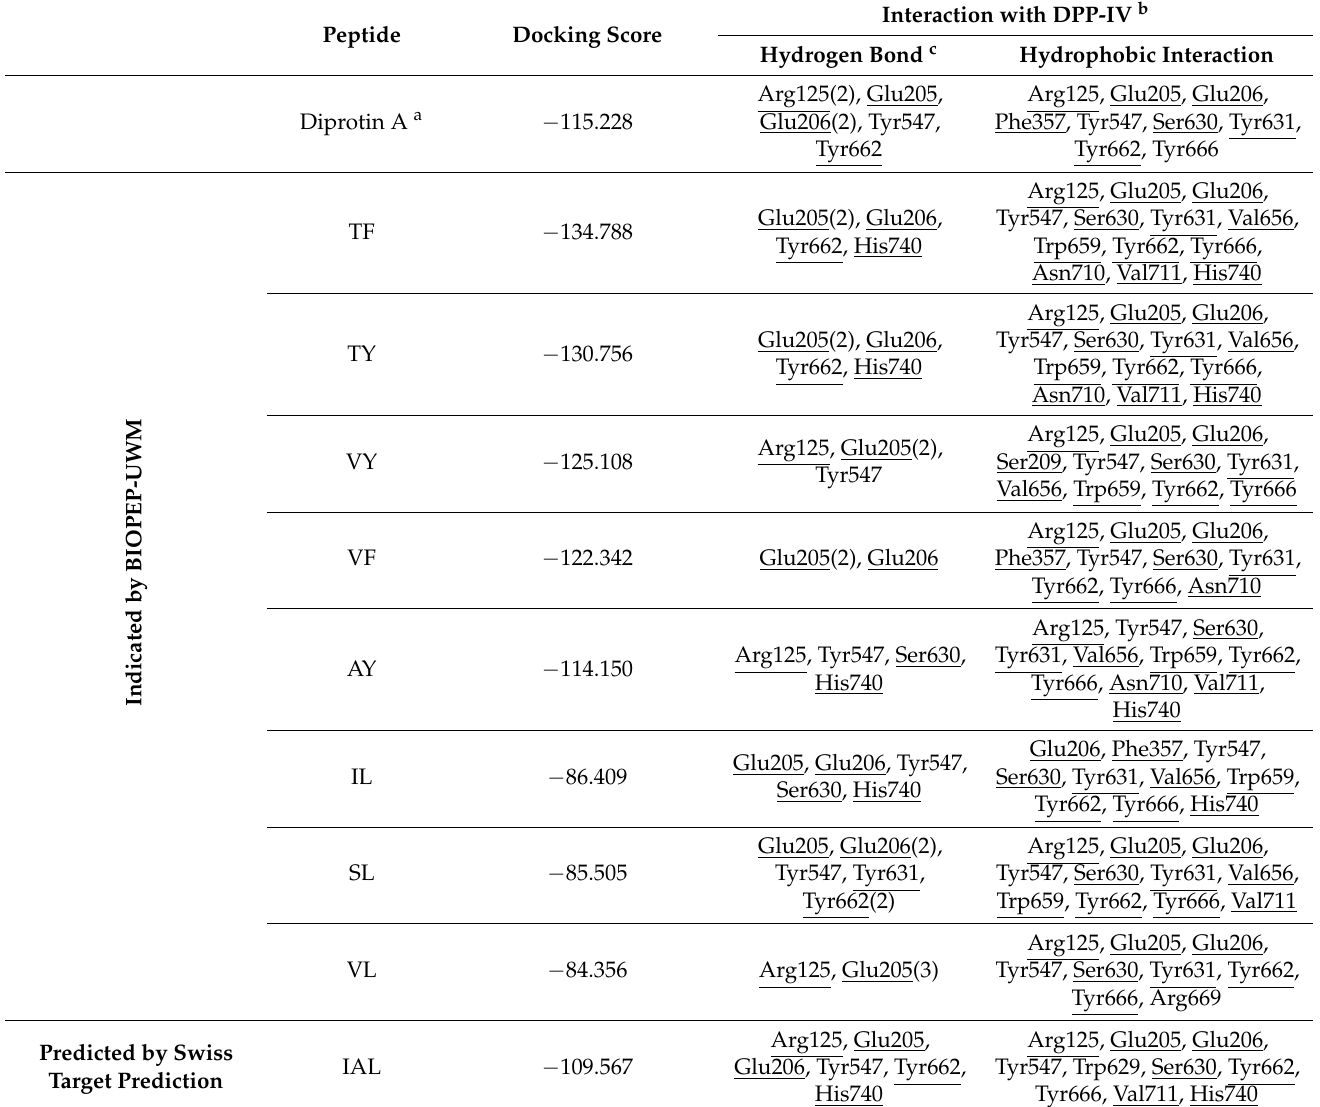
Table 6. Docking scores and intermolecular interactions between DPP-IV and known/predicted anti-DPP-IV peptides. Interaction with DPP-IV b Peptide Docking Score Hydrogen Bond c Hydrophobic Interaction Diprotin A a −